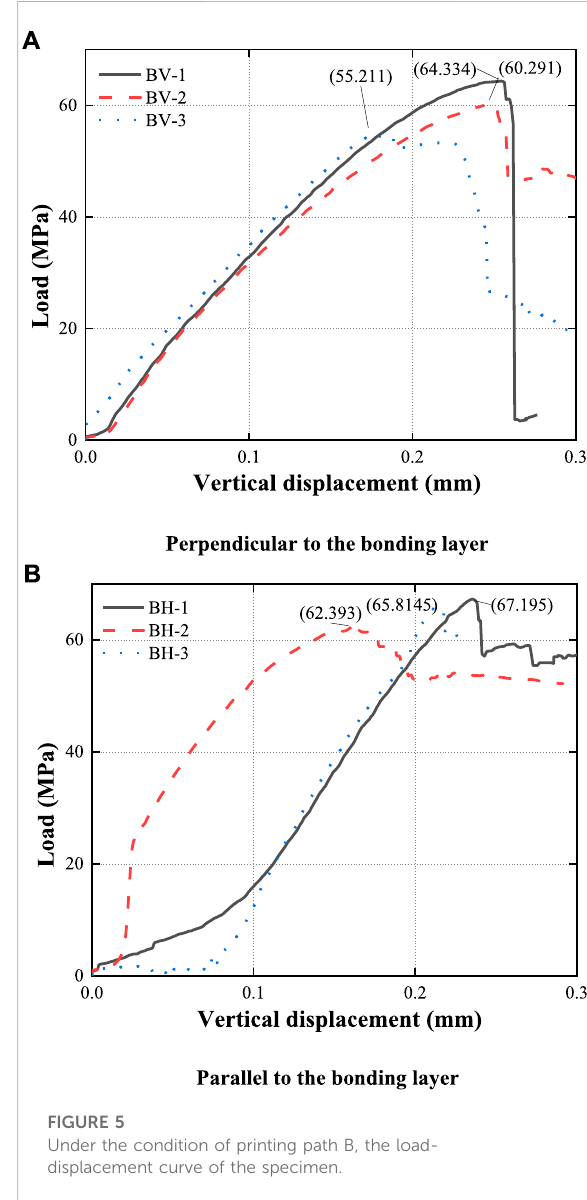
FIGURE 4 Undertheconditionofprintingpath1,theload-displacement curve of the specimen.